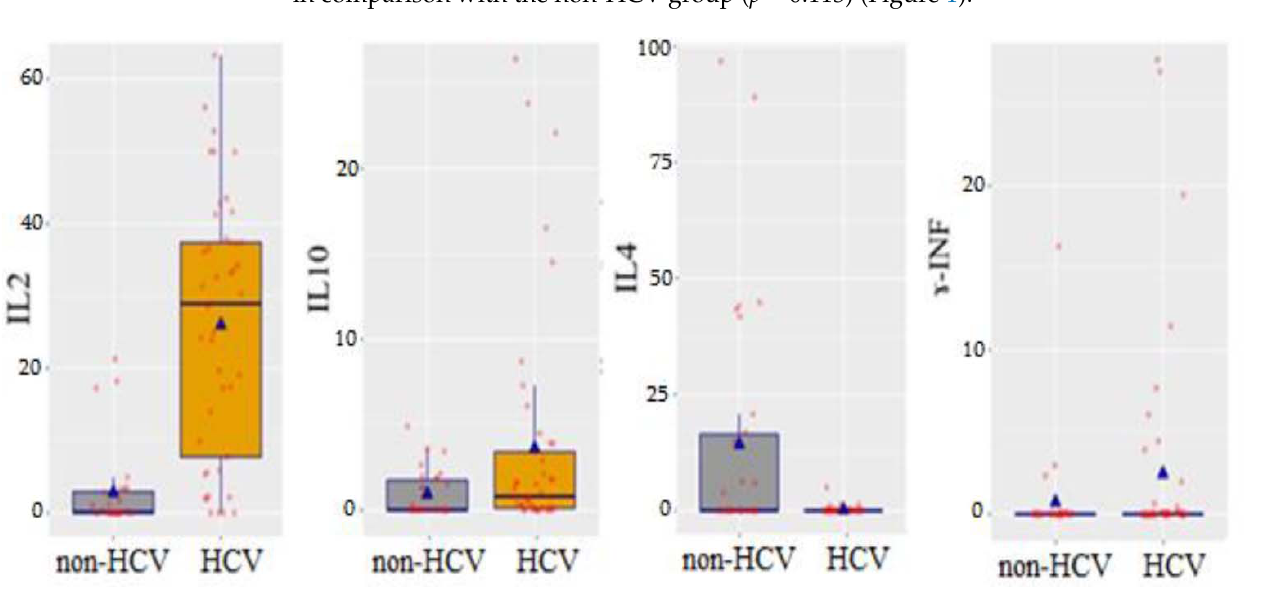
Figure 1. Oral fluid cytokine levels (IL-2, IL-10, IL-4 and ɤ -INF) in HCV patients and non-HCV group.